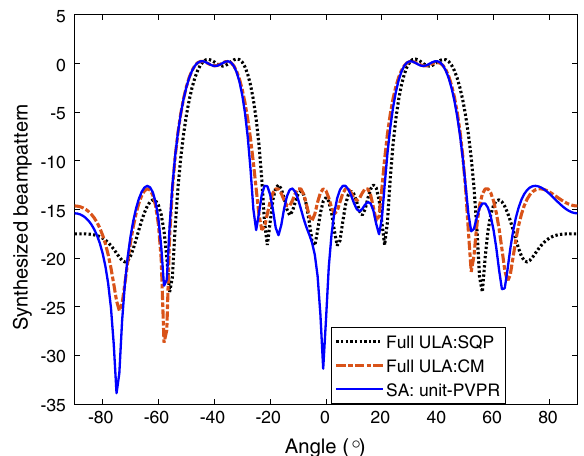
Fig. 8 Wide-mainlobe beampattern comparison of the proposed SA with the full